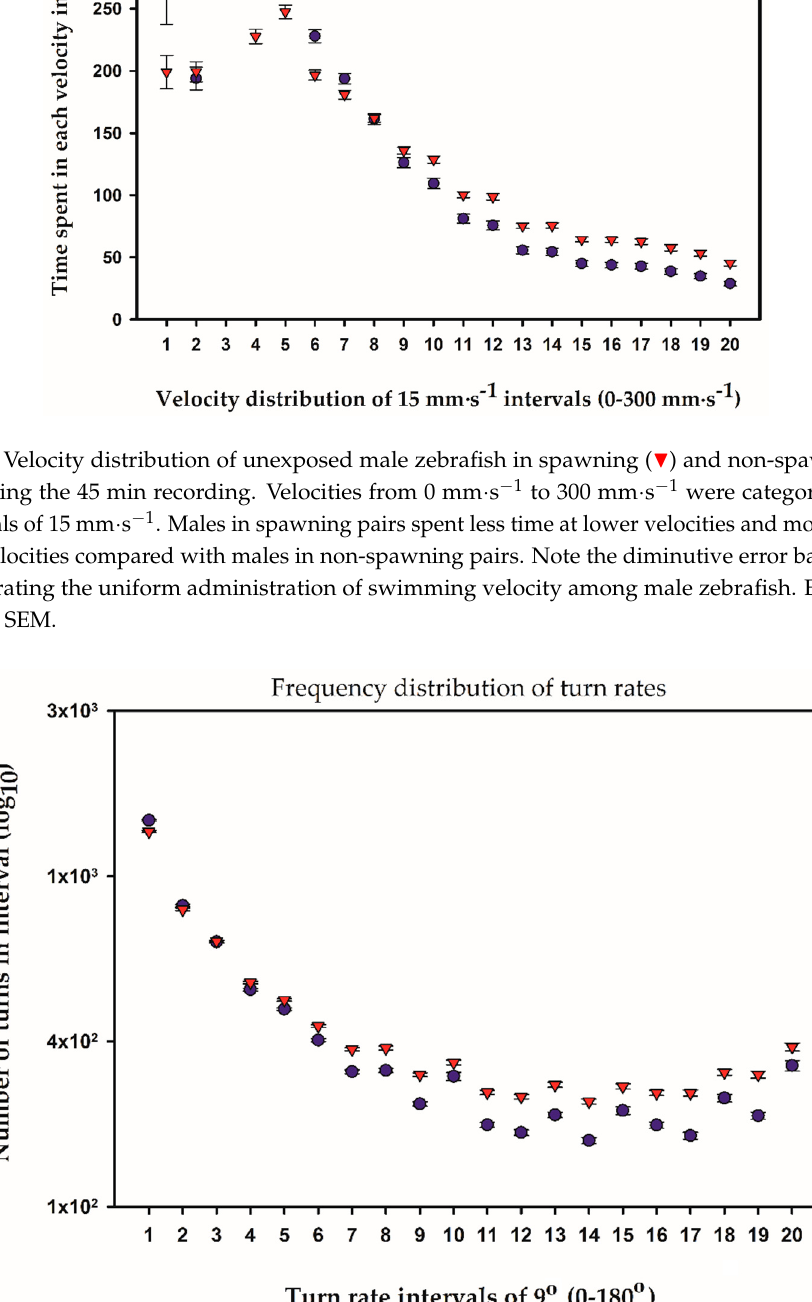
Figure 3. Average turn rate of unexposed male zebrafish in spawning ( ▼ ) and non-spawning ( ● ) pairs during the 45 min recording. Turn rates were categorized into 20 intervals of 9°, from 0° to 180°. The males in spawning pairs made more turns above 45° than males in non-spawning pairs. The high number of turns arises because of the 16 Hz sampling rate, producing 43.200 angles. Note the logarithmic Y -axis. Note also the diminutive error bars (SEM), demonstrating the very uniform turning behavior in male zebrafish.